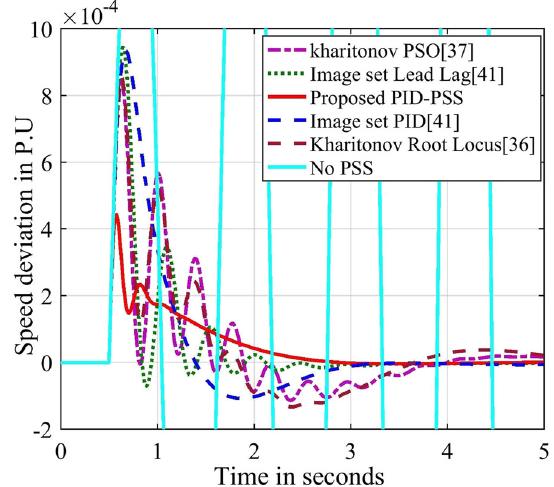
Fig. 11 Comparision of speed deviation response of the proposed with existing methods to 0.1 p.u torque disturbance at P = 1 p.u. and Q =